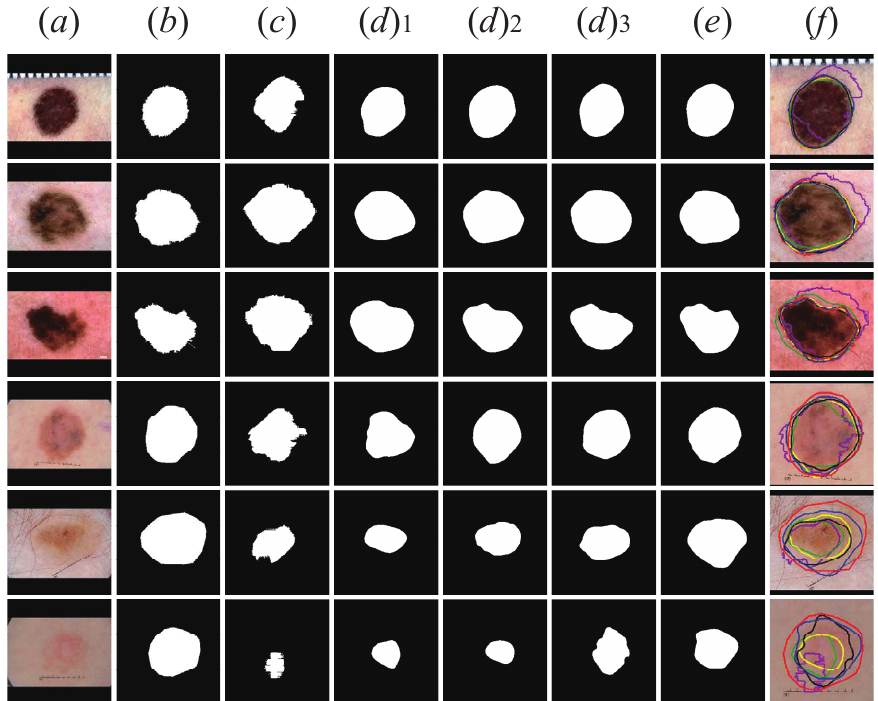
Figure 8. Visualized results of structural ablation experiments. The first two lines are Benign Nevus, the middle two lines are Melanoma lesions, and the last two lines are Seborrheic Keratosis lesions. ( a ) Original image; ( b ) the ground truth; ( c ) U-Net; ( d ) 1. M-Net; ( d ) 2. M-Net+Dense Convolu- tions; ( d ) 3. M-Net+ CSFAG; ( e ) CSAG and DCCNet model; ( f ) ground truth (red) and U-Net+ (purple), MNet (green), M-Net+Dense Convolutions (yellow), M-Net+CSFAG (black) and ours (blue) segmentation results comparison chart. All pictures are